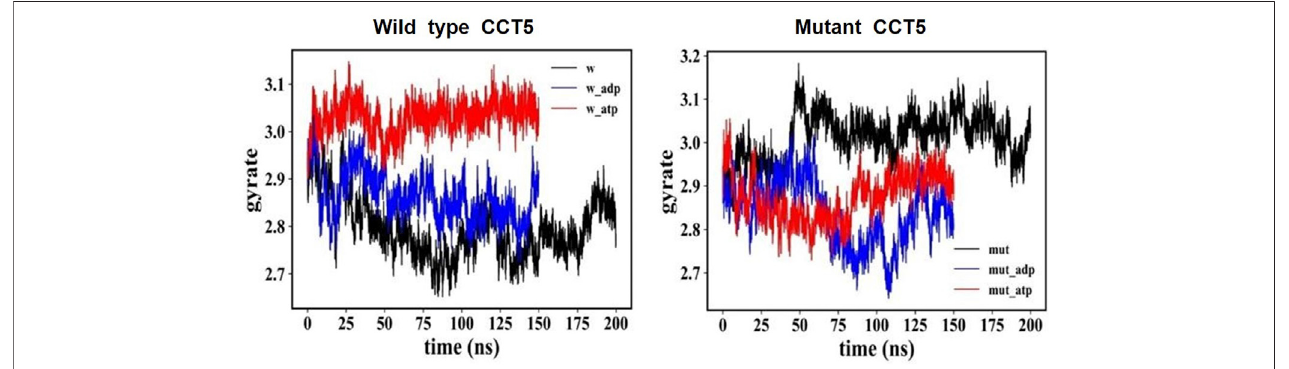
FIGURE 11 | Distribution of atomic masses in the wild type and mutant CCT5 by radius of gyration analysis. Comparison of the radius of gyration of wild type (left panel) and mutant (right panel) CCT5 subunits as a function of time was done under the three conditions studied: nucleotide free (black), ATP bound (red), and ADP bound (blue).